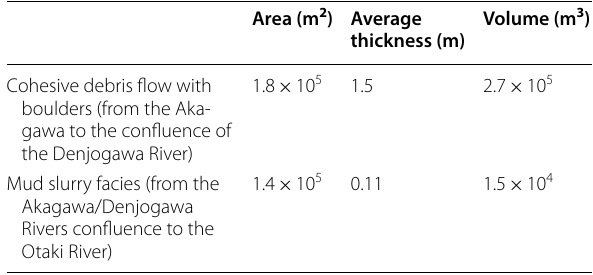
Area (m 2 ) Average Volume (m 3 ) thickness (m)